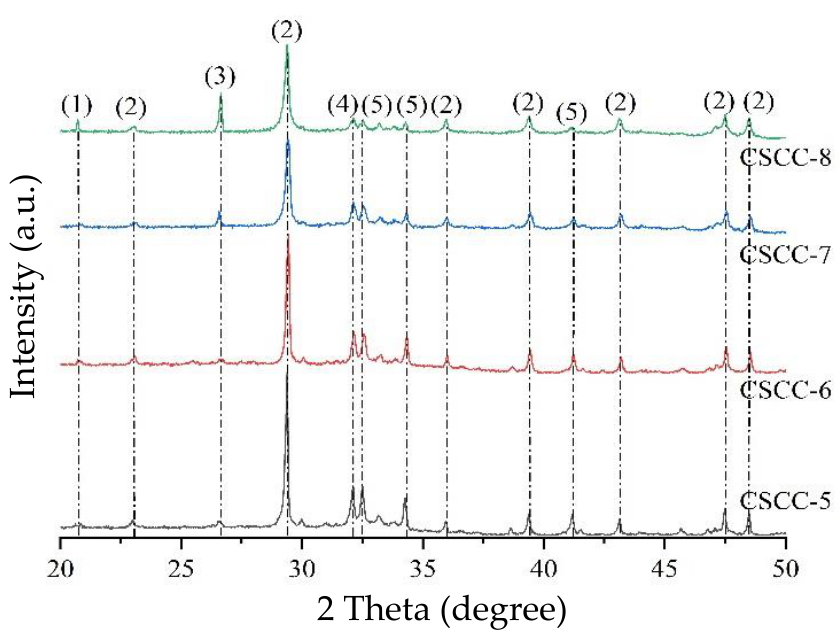
Figure 12. Fifty-six day XRD pattern: (1) gypsum, (2) Portlandite, (3) quartz, (4) calcium magnesium aluminum oxide silicate, (5) calcite silicate.